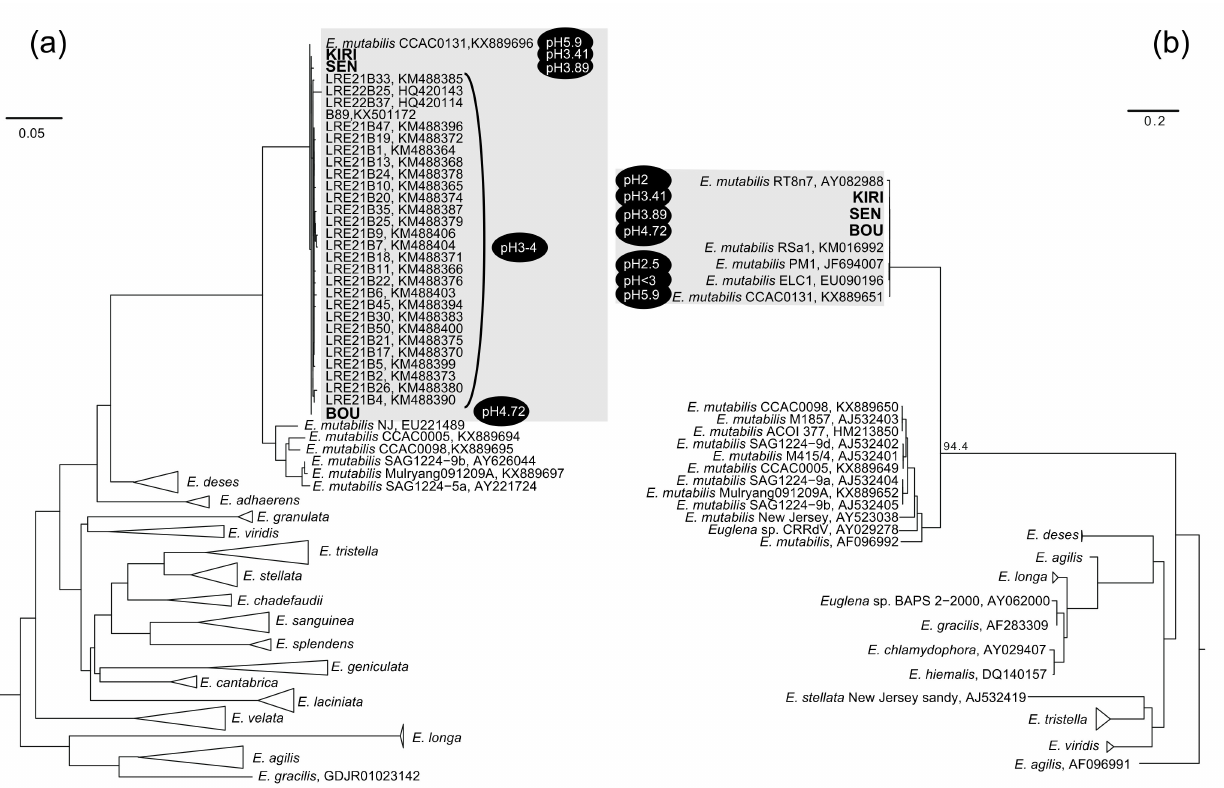
Figure 2. Phylogenetic tree of plastid SSU rRNA genes ( a ) and nuclear SSU rRNA genes ( b ) to show the phylogenetic position of the strains SEN, BOU, and KIRI in the context of the Euglenoids group. The sequences in bold were obtained in this study. Bootstrap values are expressed as percentages of 1000 trials. The values at the nodes represent scores greater than 50%. The Euglena mutabilis group with a high similarity (greater than 98%) are shaded, in which all available sequences from NCBI database were